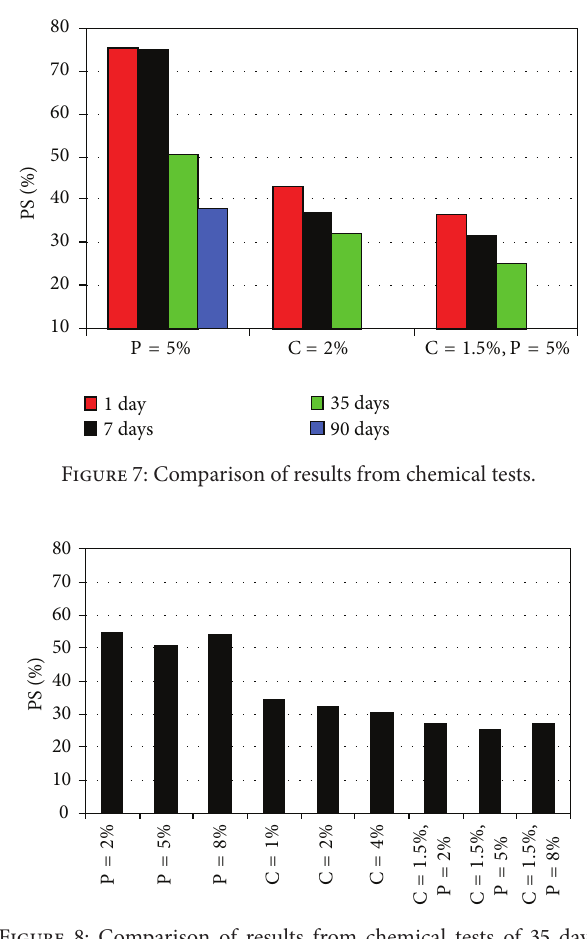
Figure 8: Comparison of results from chemical tests of 35 days curing time.